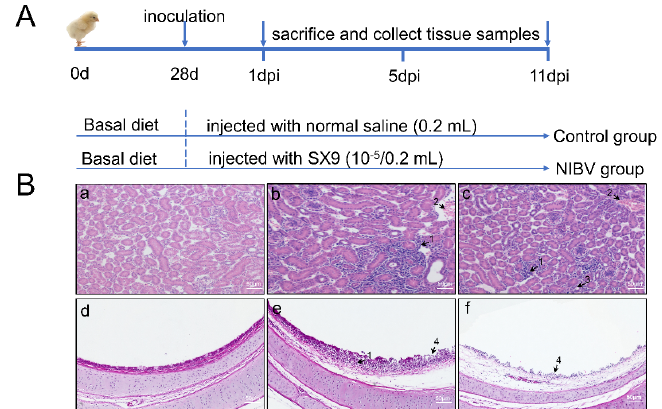
Figure 4. NIBV infection aggravates the histological lesions of tracheal tissues and renal tissues in the chicken. ( A ) The schematic illustrations of experimental design. ( B ) Histological analysis of chicken kidneys and tracheae. a, d is the normal renal tissue section and trachea tissue section, re- spectively; b, c, and e, f are the representative images of tracheal tissues and renal tissues at 11 dpi showing histopathological changes in NIBV-infected chickens. 1: Serous fluid and inflammatory cell infiltration; 2: blood cell infiltration; 3: the absence of tubular structures; 4: most of the cilia shed and the mucosal epithelial cells were degenerated, necrotic, and